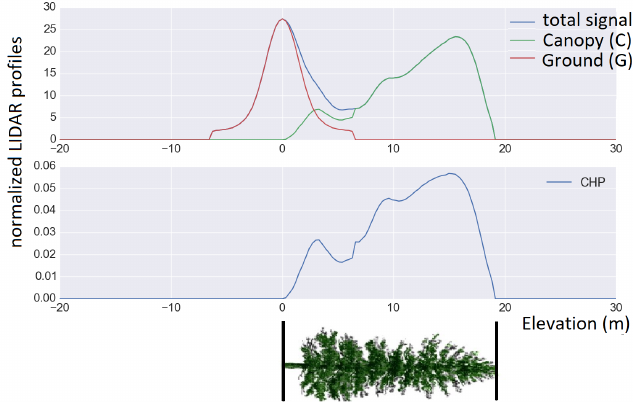
Figure 10. Canopy Height profile